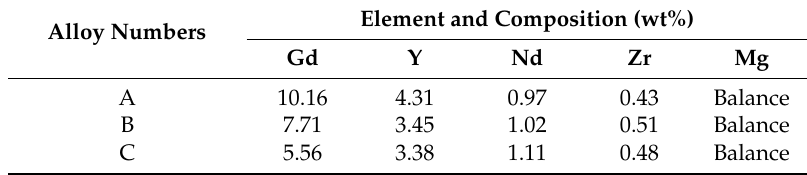
Table 1. Chemical composition of the three designed alloys A, B, and C. Element and Composition Alloy Numbers